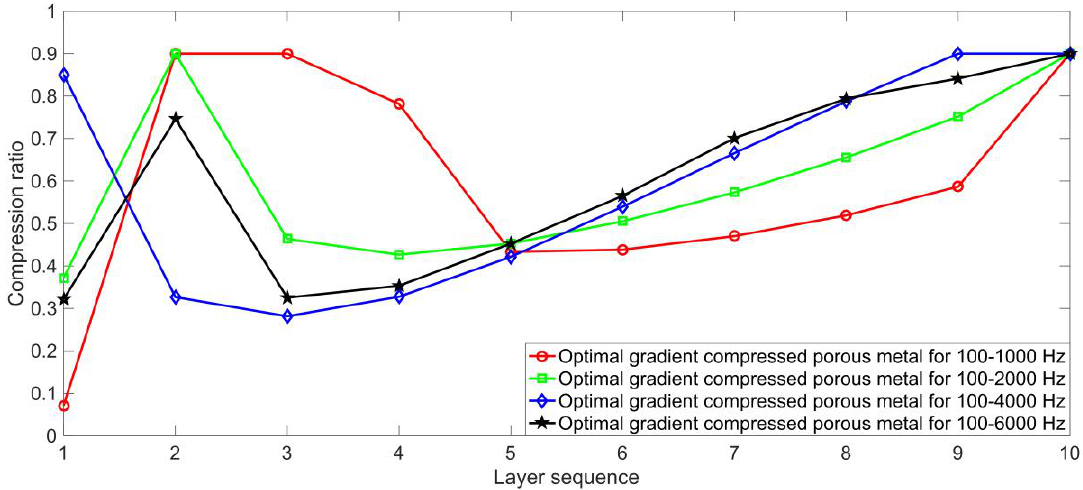
Figure 9. Distributions of compression ratio of optimal 10-layer gradient compressed porous metals.